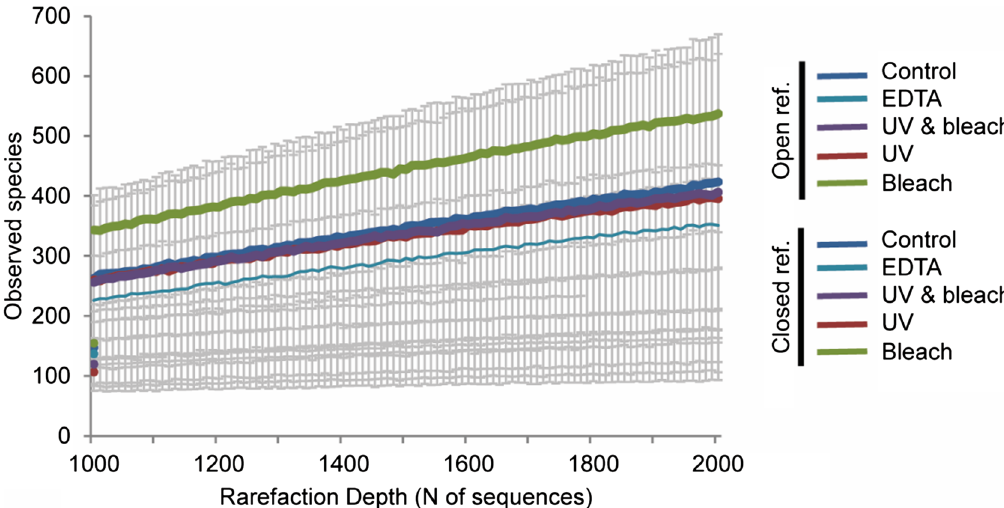
Figure 3. Average alpha diversity within protocols. Lines represent the average alpha diversity (observed species) of all samples processed with the same decontamination protocol. Dotted lines signify the diversity calculated within the closed reference OTUs (OTUs identified in the GreenGenes database) and solid lines represent diversity detected within the open reference OTUs (Closed reference OTUs plus OTUs without matching sequences in the GreenGenes database). The colours represent the different protocols, and the error bars (one standard deviation) are shown in